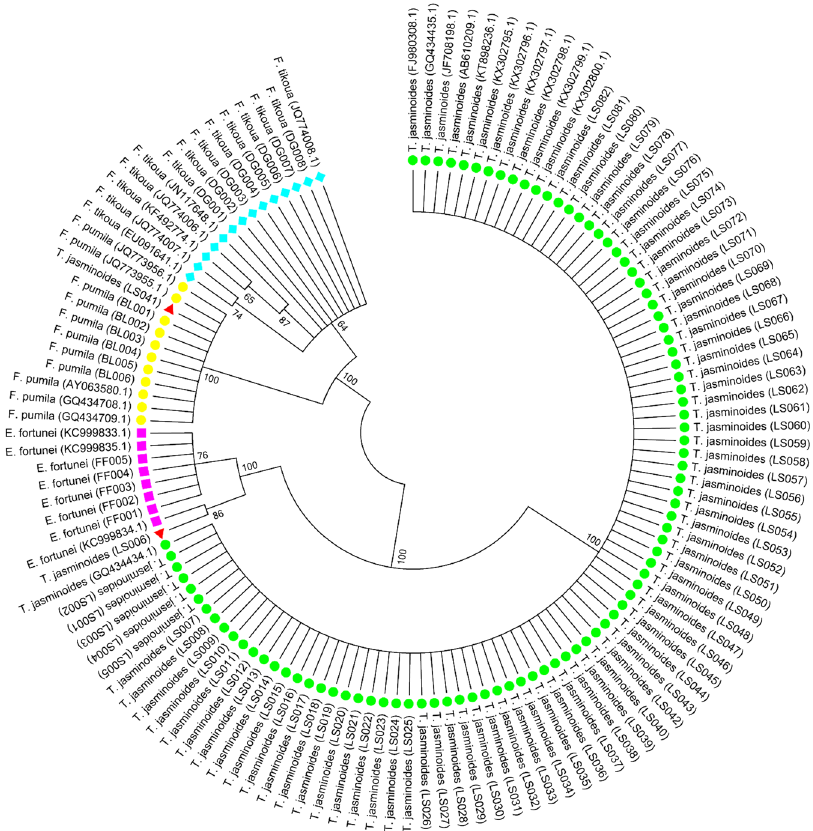
Figure 3. NJ tree of T. jasminoides and its adulterants constructed with ITS2 sequences. The 1000 replicates bootstrap scores are shown ( ≥ 60) for each